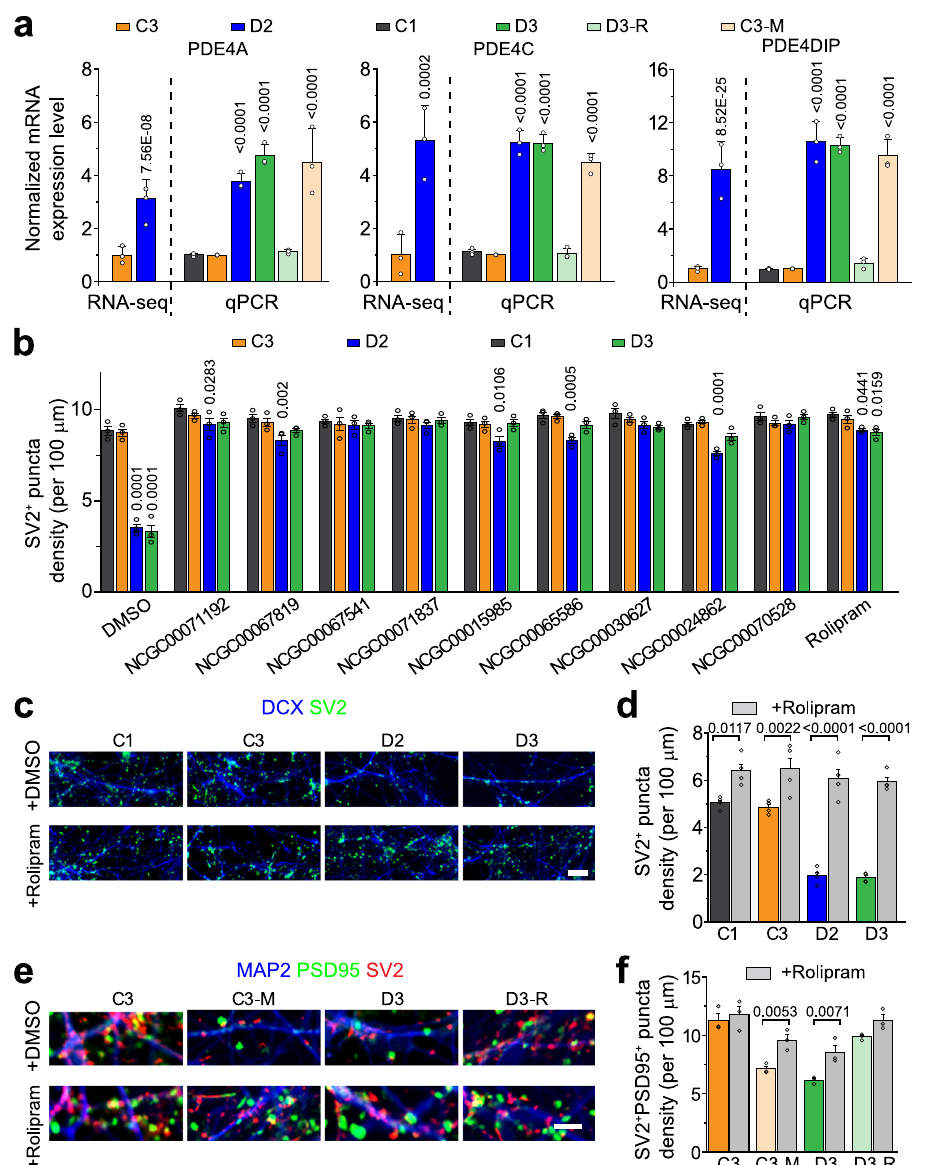
Fig. 1 Mechanism-guided pharmacological rescue of synaptic defects of human neurons carrying the DISC1 mutation. a Summary of q-PCR validation of RNA-seq results of increased mRNA levels of PDE4A, PDE4C, and PDE4DIP in human forebrain neurons carrying the DISC1 mutation (D2 and D3: neurons derived from patient iPSC lines with DISC1 mutation; C1 and C3: neurons derived from control iPSC lines; C3-M: neurons derived from an isogenic knock-in DISC1 mutant line under the background of the C3 control iPSC line; D3-R: neurons derived from an isogenic DISC1 mutant correction line under the background of the D3 patient iPSC line). Values represent mean ± s.d. ( n = 3 independent differentiation cultures for qPCR analysis; comparison to C3 using One-way ANOVA with p values indicated). b Effects on the density of SV2 + synaptic puncta in 6-week old forebrain neurons upon treatment with different small molecules. NCGC00071192: 2 µ M; NCGC00067819: 2 µ M; NCGC00067541: 2 µ M; NCGC00071837: 2 µ M; NCGC00015985: 10 µ M; NCGC00065586: 10 µ M; NCGC00030627: 20 µ M; NCGC00024862: 20 µ M; NCGC00070528: 10 µ M; Rolipram: 100 nM. Values represent mean ± s.e. m. ( n = 3 independent differentiation cultures; comparison to C1 using One-way ANOVA with p values indicated). c – d Representative confocal images of 4-week old neurons from different iPSC lines immunostained with SV2 and DCX upon vehicle (DMSO) or Rolipram (100 nM) treatment. Scale bar, 20 μ m ( c ). Also shown is the quanti fi cation of SV2 + puncta density in neurons derived from different iPSC lines with or without Rolipram treatment ( d ). Values represent mean ± s.e.m. ( n = 4 independent differentiation cultures; One-way ANOVA with p values indicated). e – f Representative confocal images of 4- week old neurons co-cultured with astrocytes from different iPSC lines immunostained with SV2, PSD95, and MAP2 upon vehicle (DMSO) or Rolipram (100 nM) treatment. Scale bar, 20 μ m ( e ). Also shown is the quanti fi cation of SV2 + PSD95 + puncta density in neurons derived from different iPSC lines with or without Rolipram treatment ( f ). Values represent mean ± s.e.m. ( n = 3 independent differentiation cultures; One-way ANOVA with p values indicated). Source data are provided as a Source Data fi